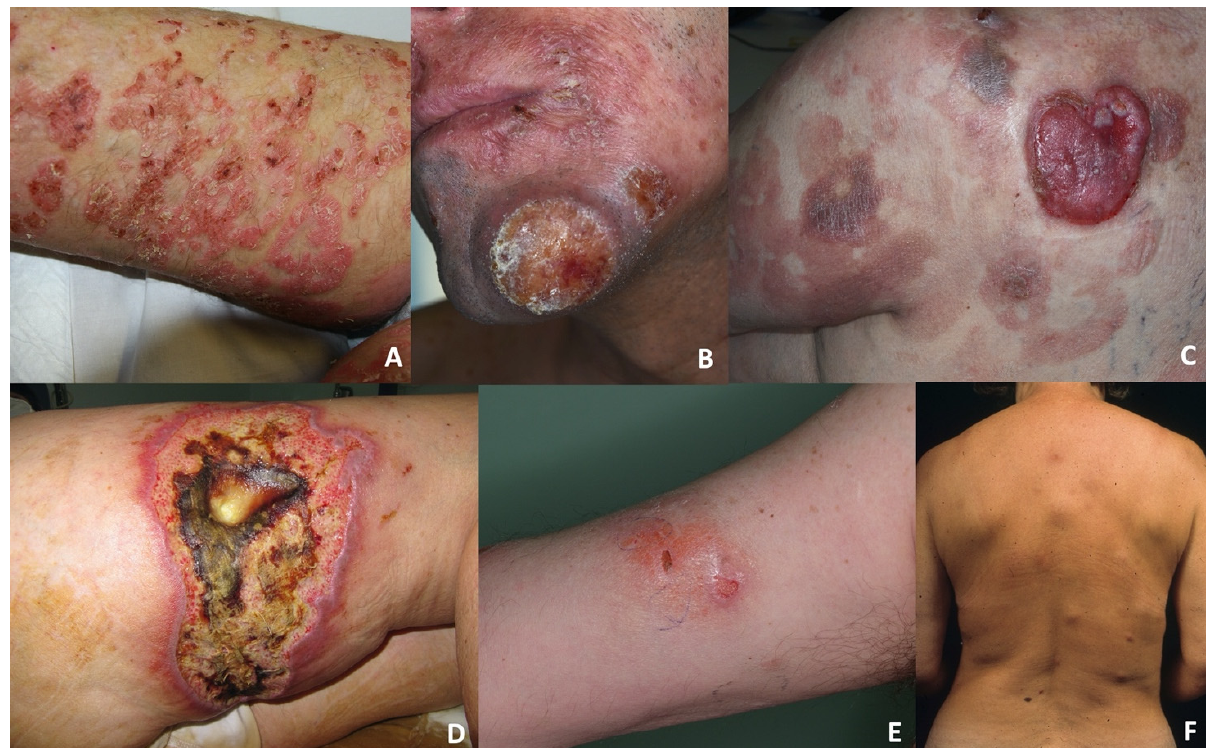
Figure 1. ( A ) A DE-GDTCL patient presenting with pagetoid reticulosis characterised by diffuse superficial patches and plaques. ( B ) An ulcerated tumour on the face of a DE-PCGDTCL patient. ( C ) A tumour associated with MF-like plaques on the back of a DE-PCGDTCL patient. ( D ) Pyoderma gangrenosum-like plaques on the leg of a S-PCGDTCL patient. ( E ) A deep erythematous plaque on the arm of an S-PCGDTCL patient. ( F ) Multiple deep nodules on the back of an S-PCGDTCL patient.